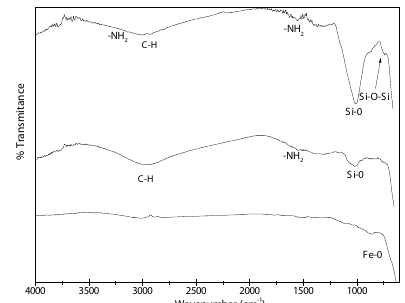
Figure 3. FTIR of magnetite (M), magnetite-aminosilane (MA) and magnetite-silica-aminosilane (MSA) obtained by reflux and aging